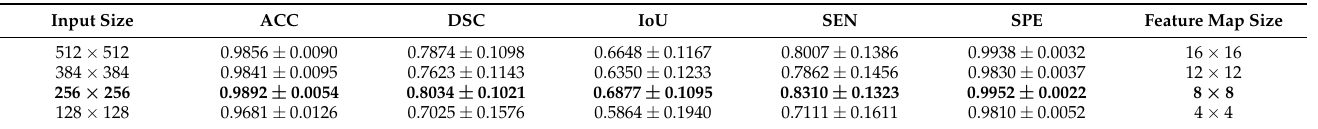
Figure 12. Different examples of channel attention maps (CAMs) obtained from the LungINF- seg. ( a – d ) present examples of COVID-19 infection in CT images ( left ) and the corresponding CAMs ( right ). Table 4. The performance of the LungINFseg with different image resolutions on the test set (mean ± standard deviation). Best results are in bold.